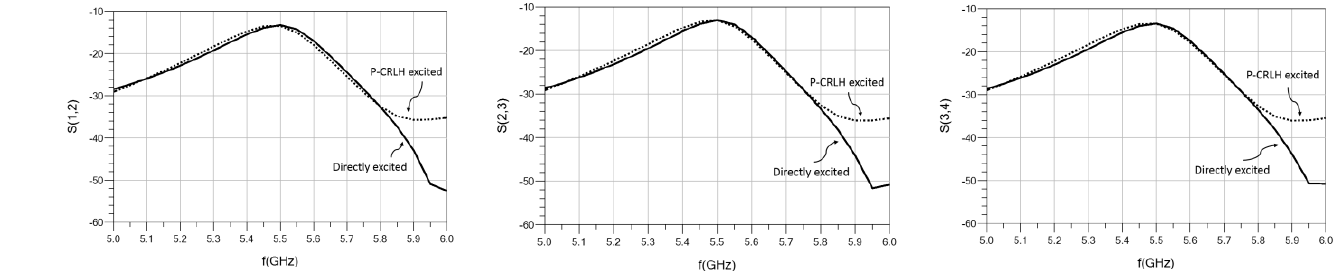
Figure 9. Simulated mutual coupling between adjacent antenna elements with P-CRLH-excited and without P-CRLH-excited (directly excited) phase shifters.